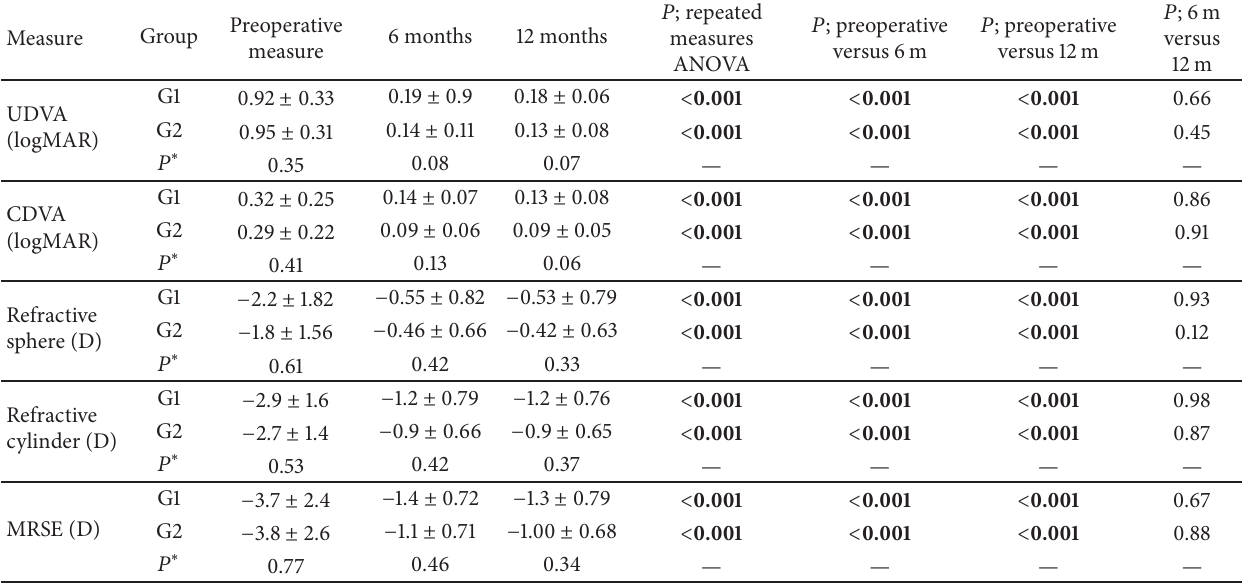
Table 3: Preoperative and postoperative visual and refractive parameters (mean ± SD) in the 2 studied groups 6 months and 12 months following the full